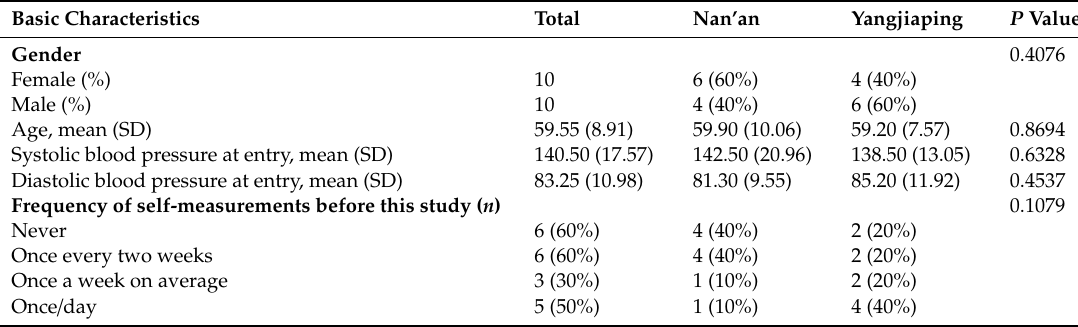
Table 2. The basic characteristics of the interviewees.